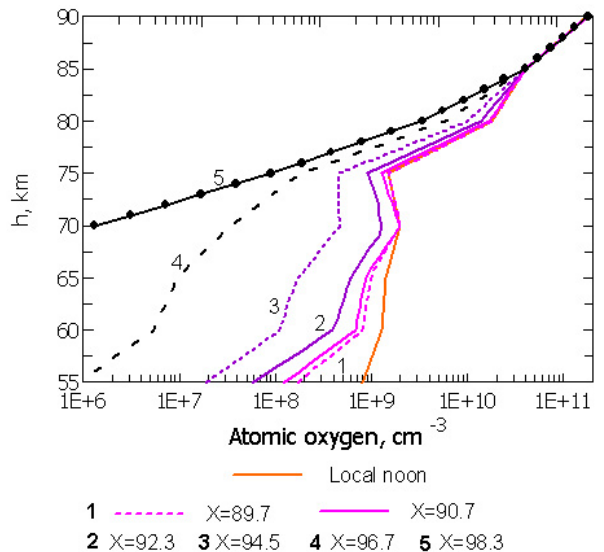
Fig. 9. The O-profiles which are consistent with the electron density profiles measured during winter SPE at various zenith angles. Red line is the O-profile at local noon.